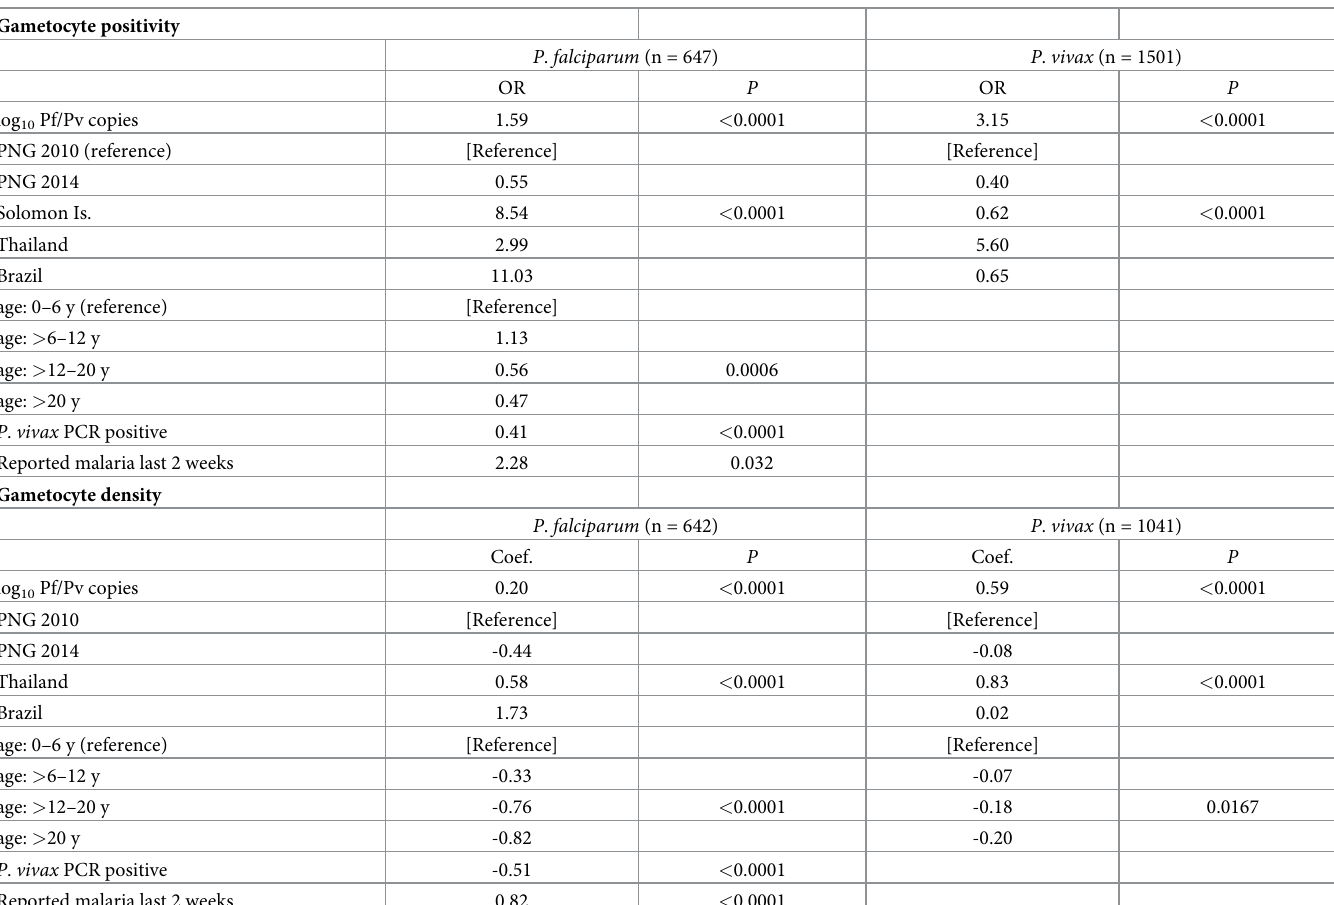
Table 3. Multivariate predictors of gametocyte positivity and density.